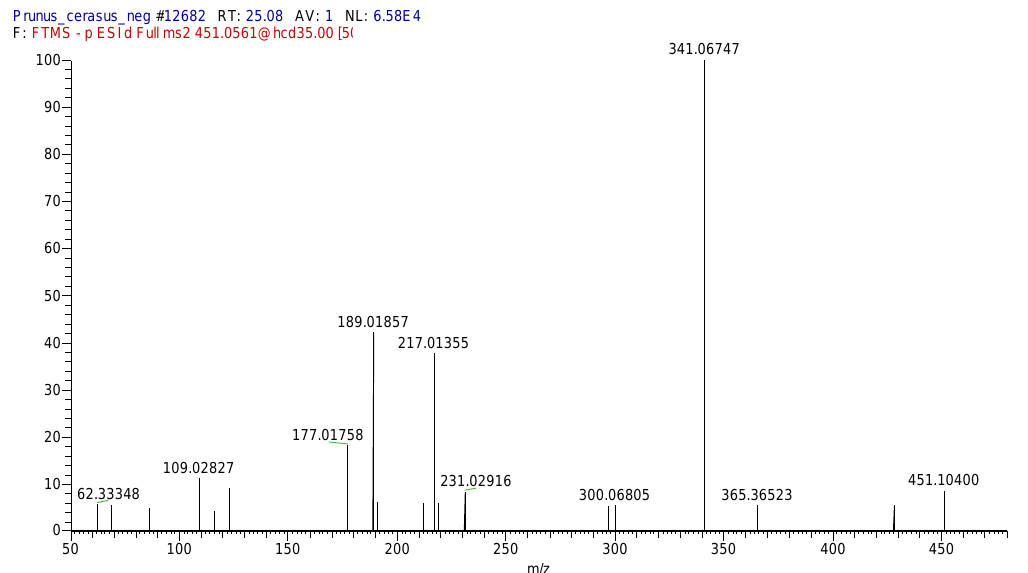
Figure 4. ESI-MS2 spectrum of Cinchonain I diastereoisomer at retention time 25.51.